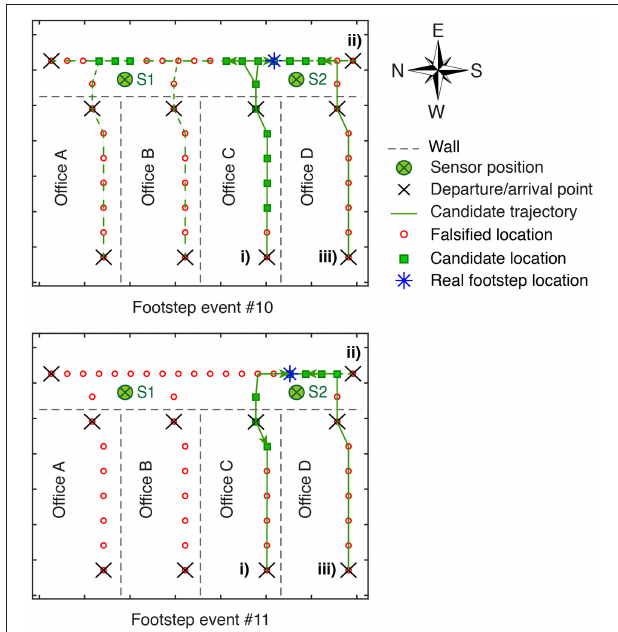
FIGURE 12 | Candidate trajectory results of trajectory #2 are shown for footstep events #10 and #11. Arrows point out candidate locations #10 and #11 from departure points. The remaining trajectories that correspond to footstep event #10 is equal to 15. Based on trajectory identification process, only four trajectories remain at footstep event #11. Each additional footstep enhances trajectory identification.